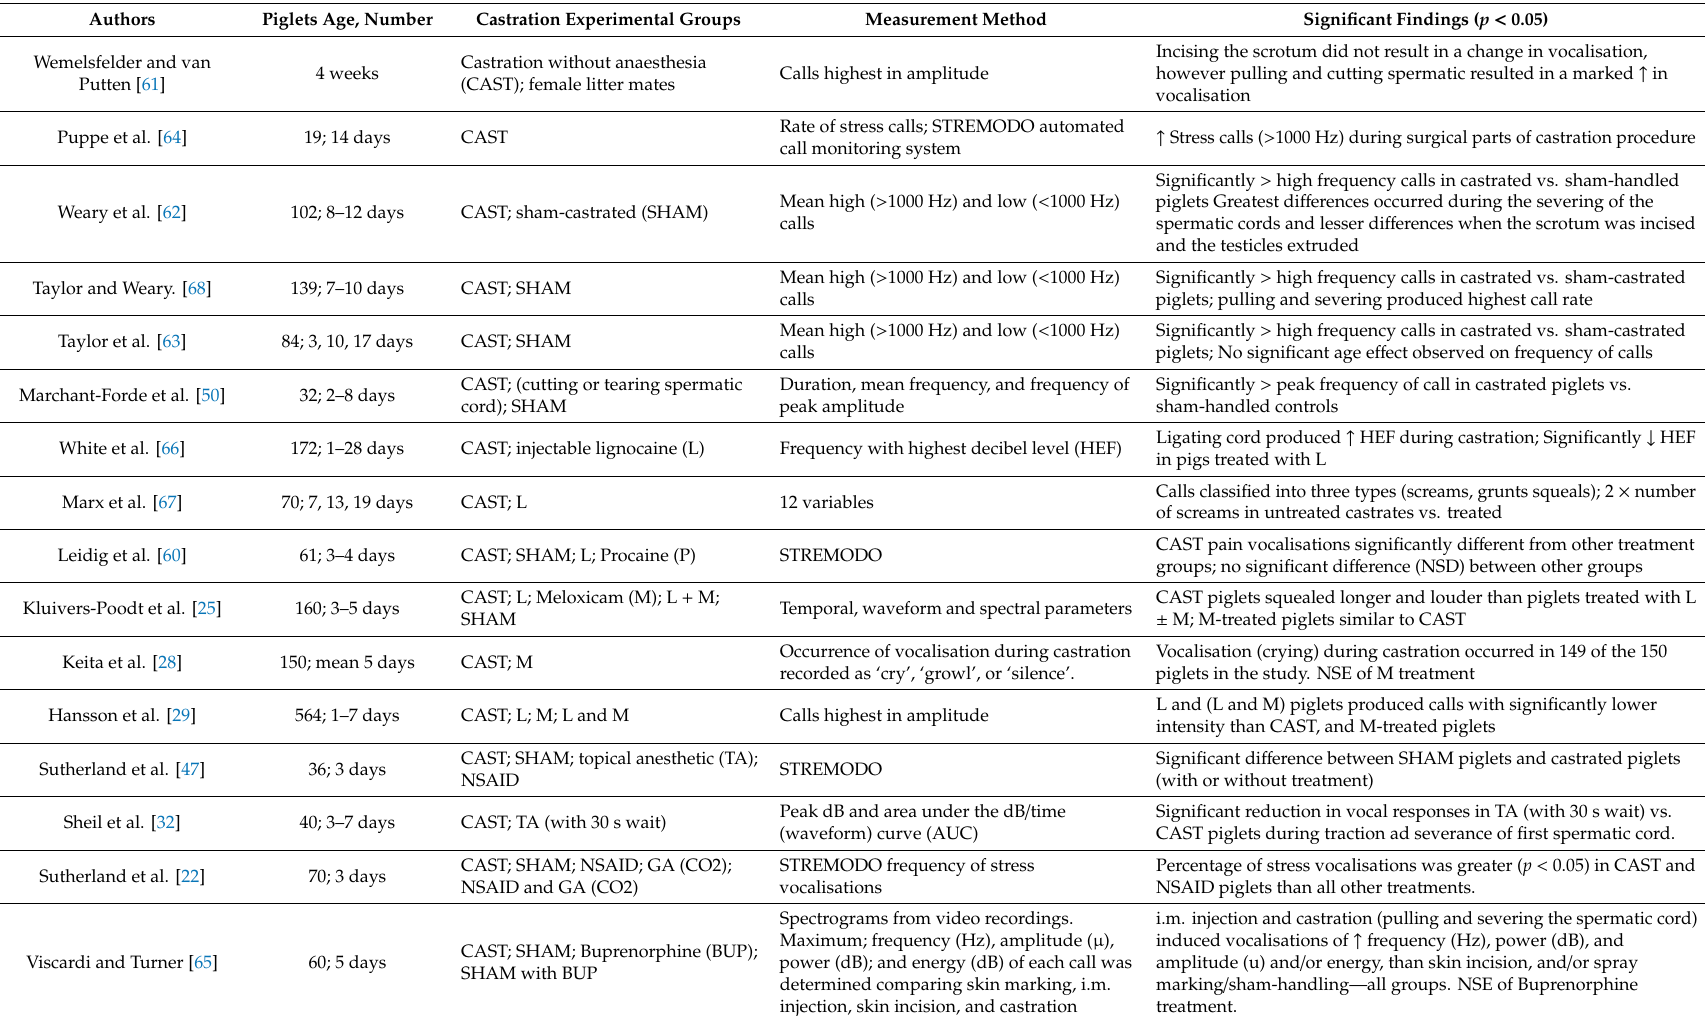
Table 3. Summary of studies measuring piglet vocal responses during